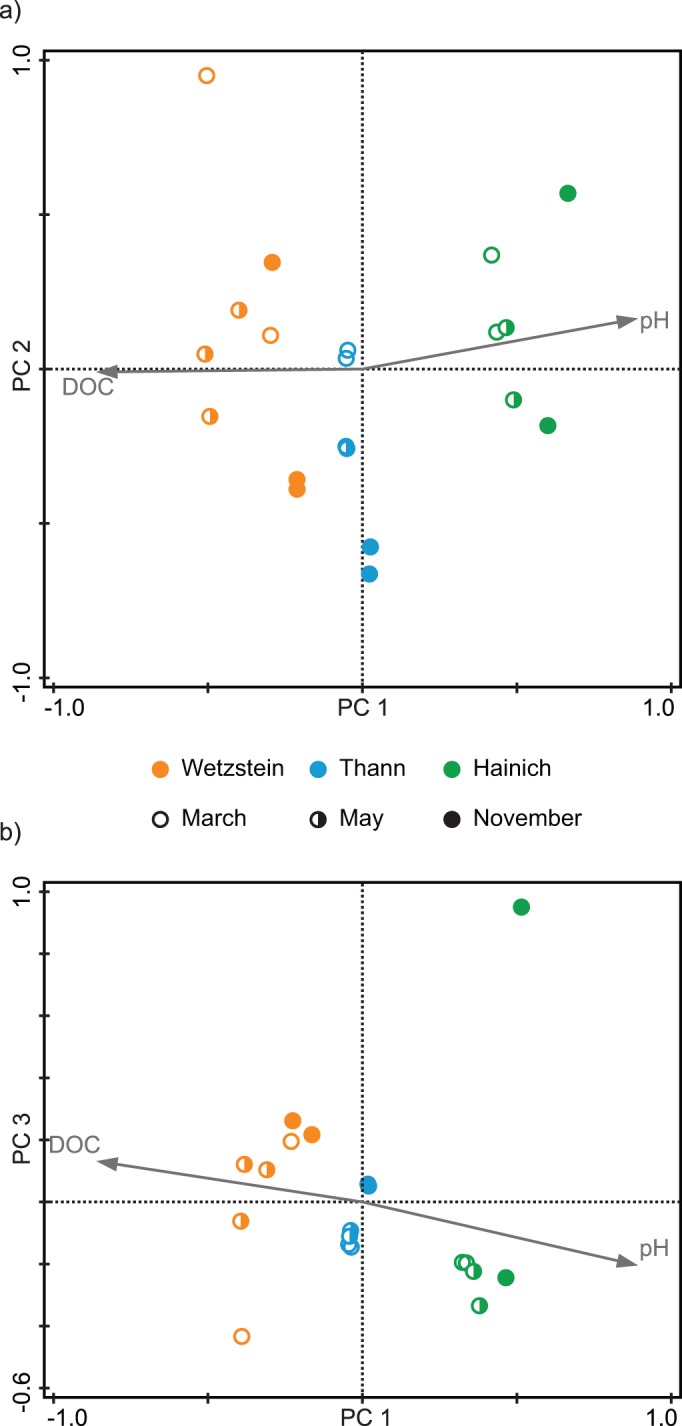
Ordination plots from PCA, based on all detected molecular formulae and their normalized FT-ICR-MS signal intensities.DOC concentration and pH were not used for PCA, but plotted as supplementary variables. Variability explained: PC1, 32.9%; PC2, 15.7%; PC3, 12.5%. (a) Plot of first and second axes, (b) plot of first and third axes.